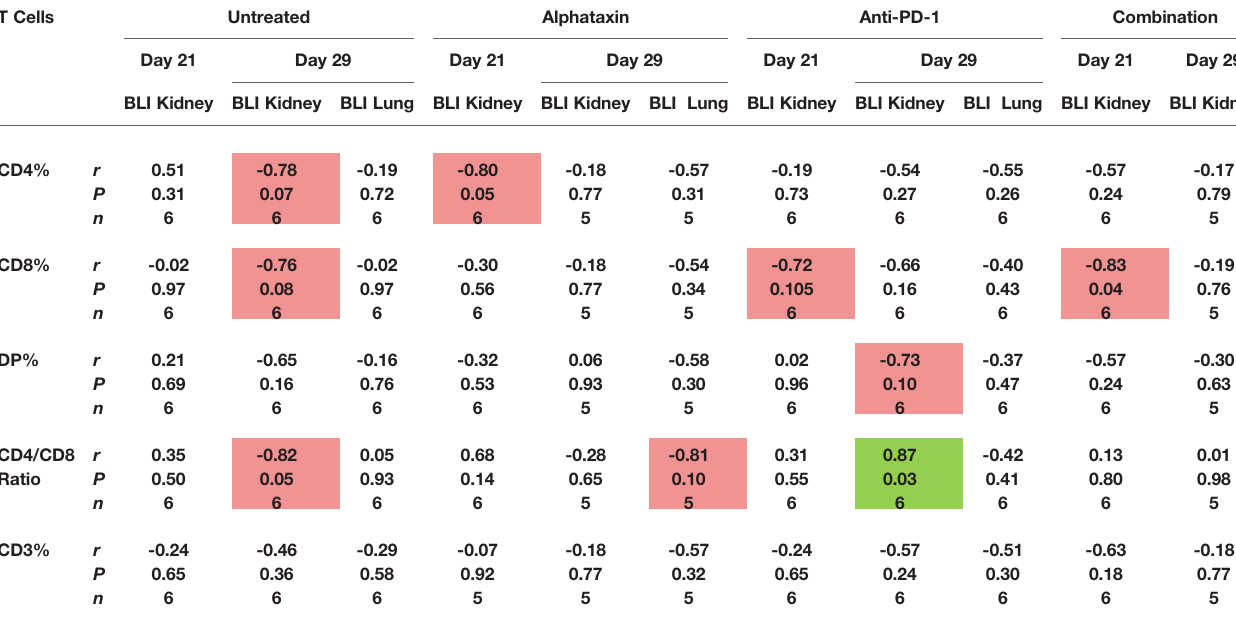
Red boxes represent negative correlations, green boxes represent positive correlations, and white boxes represent no correlation. The values depicted within each box represent correlation coef fi cients (r, top row), signi fi cance (P, middle row), and number of observations (n, bottom row). Values were normally distributed, and correlations were determined using PearsonProductMomentanalysis.WhilesomePvalues(0.05<P<0.1)couldnotbeinterpretedasstatisticallysigni fi